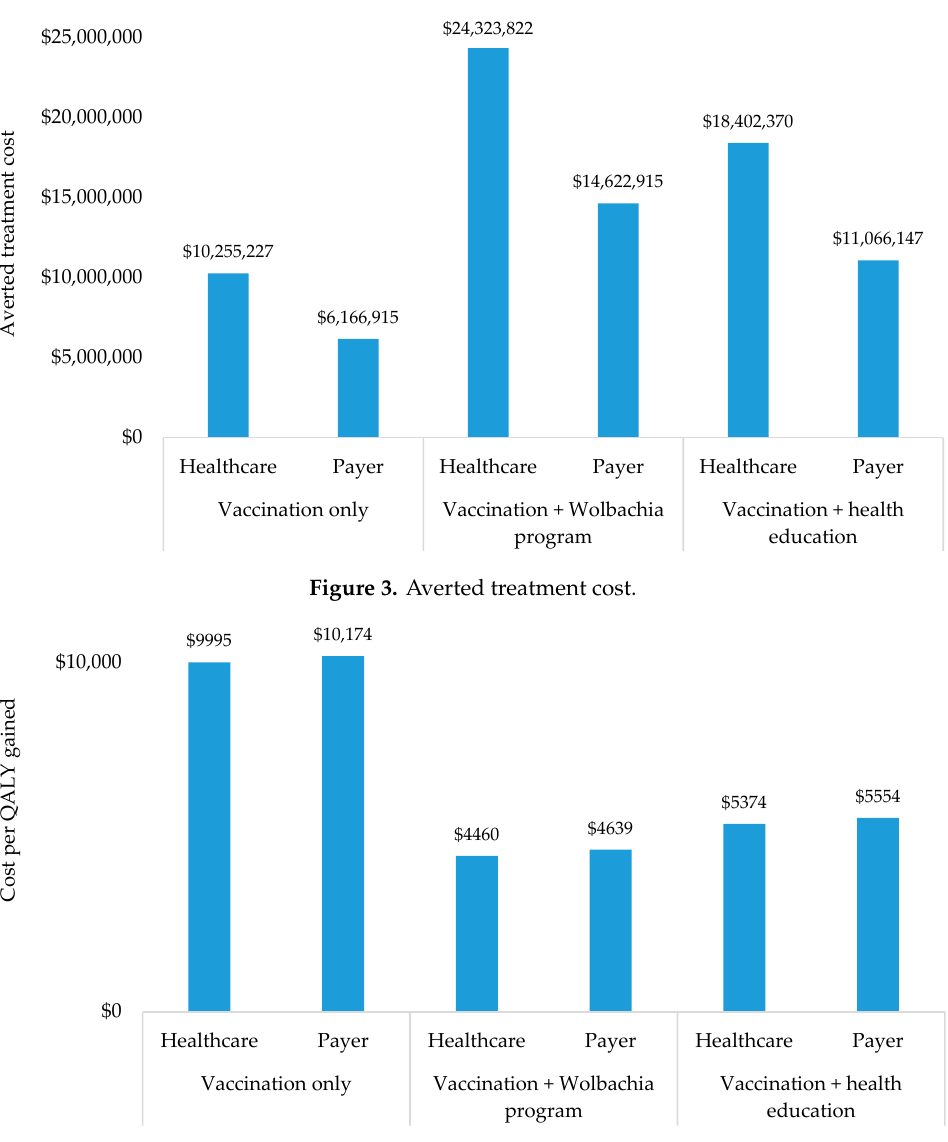
Figure 4. Incremental cost-effectiveness ratio.